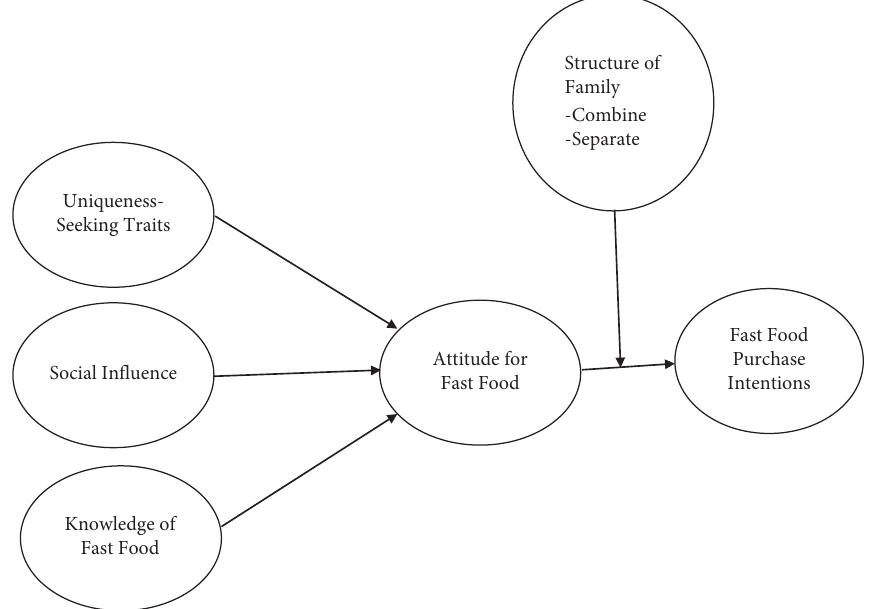
Figure 1: Conceptual